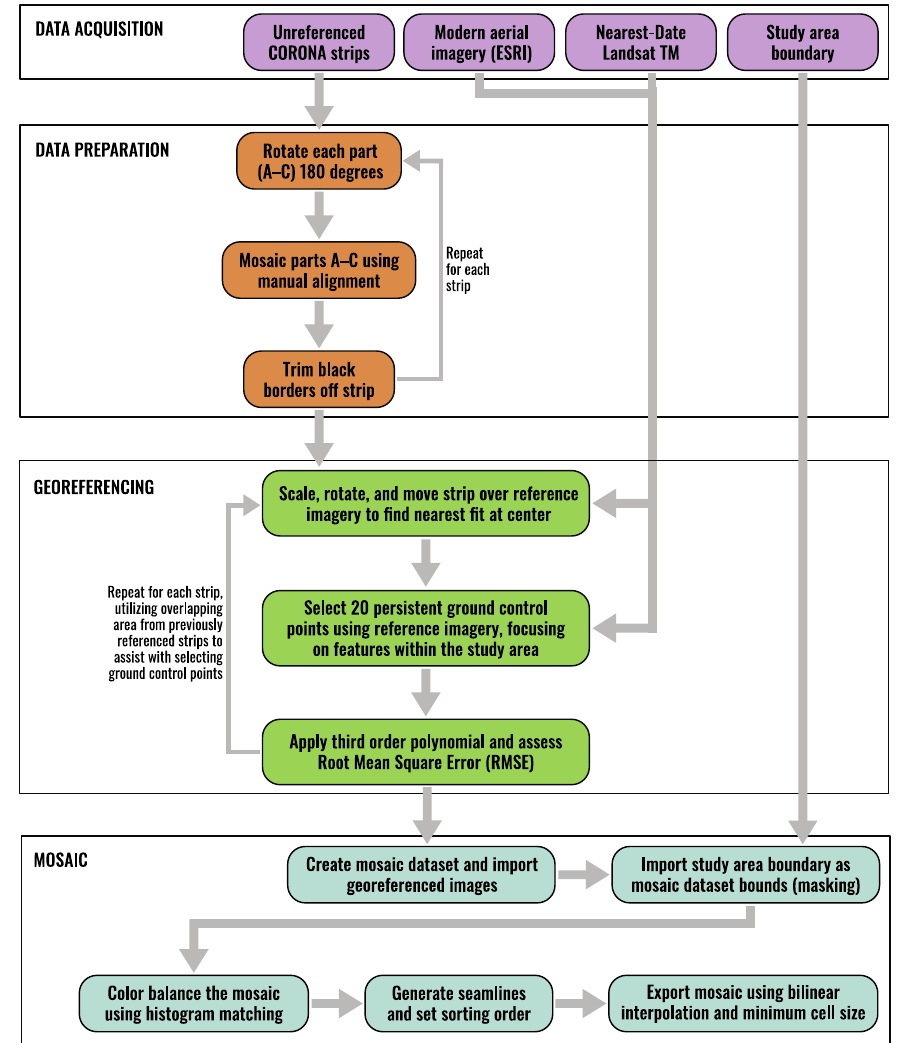
Figure 2. Approximate workflow from data acquisition through export of the final mosaicked image. Details for each step are outlined in the text.